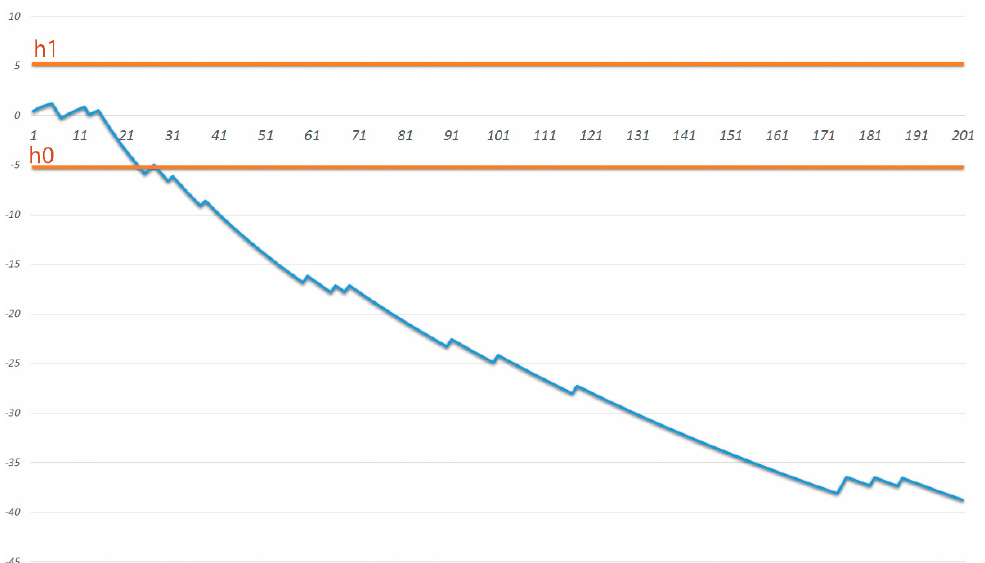
Figure 1. Risk-adjusted sequential probability ratio test (RA-SPRT) chart for incomplete cytoreduction (CCR 2/3 procedures). The x-axis represents the operation number. The y-axis represents a cumulative log-likelihood ratio value.